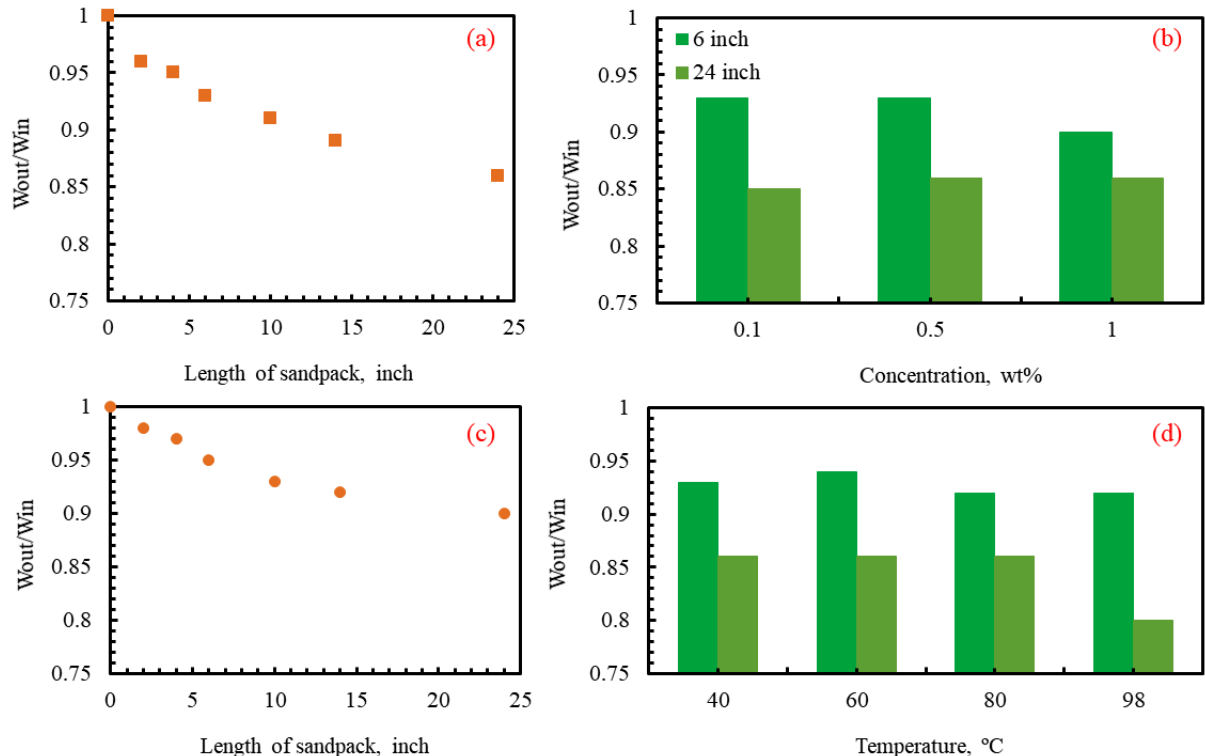
Figure 3. Silica NP retention estimation (w out /w in ) in fabricated porous formation for varying experimental conditions: ( a ): flow rate of injection (1 mL/ min); ( b ): silica NP concentration; ( c ): flow rate of injection (2 mL/min), and ( d ): temperature (40 – 95 °C).